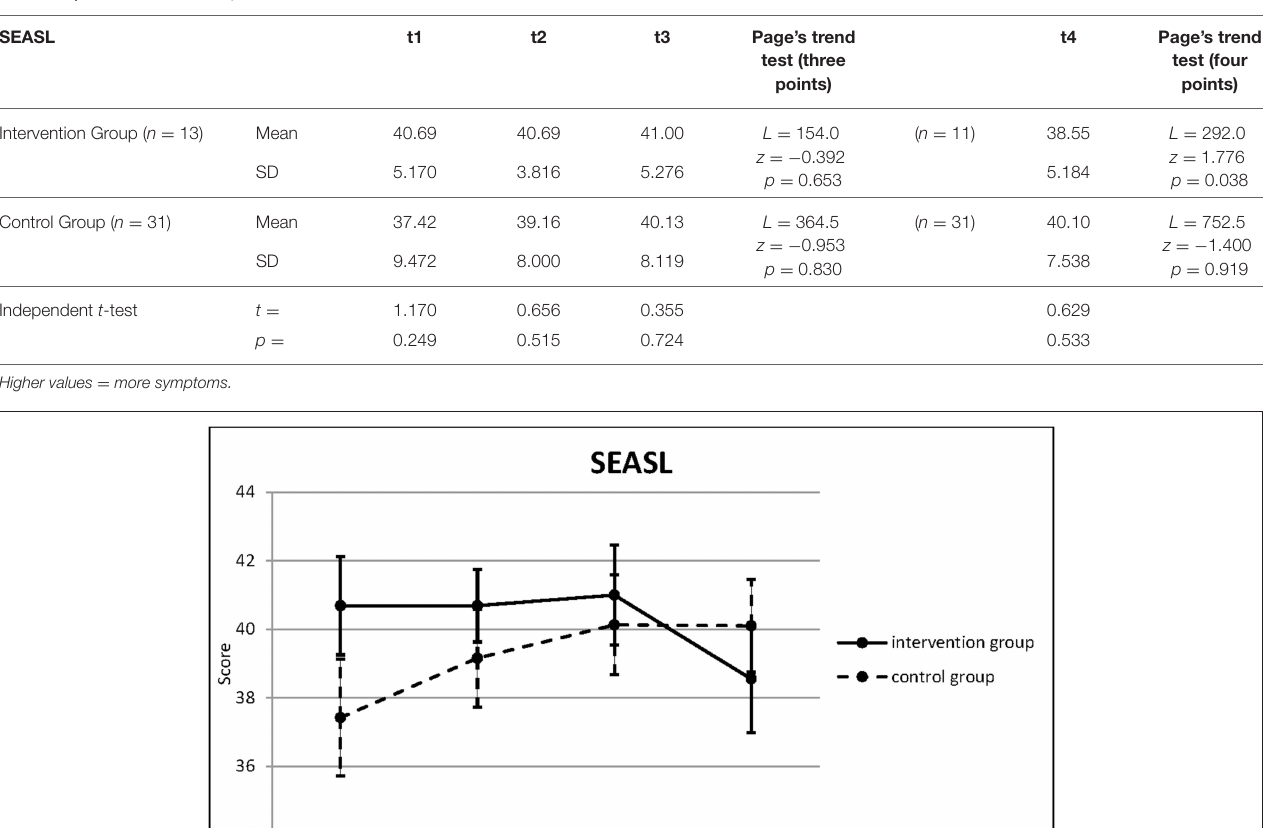
TABLE 3 | Work and Social Adjustment Scale.